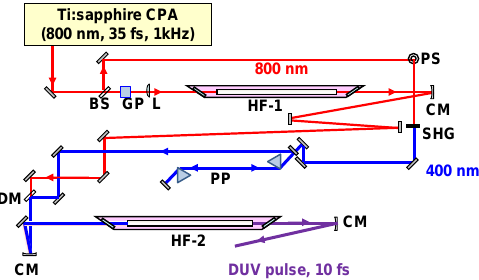
Figure 7. The schematic illustration of the generation schemes of the ultrashort DUV pulses. BS: beam splitter; GP: glass plate; L: focusing lens; HF-1, HF-2: hollow fibers; PS: periscope; SHG: second-harmonic generation crystal; PP: pulse stretcher consisting of two prisms; DM: dichroic mirror; CM: concave mirror.